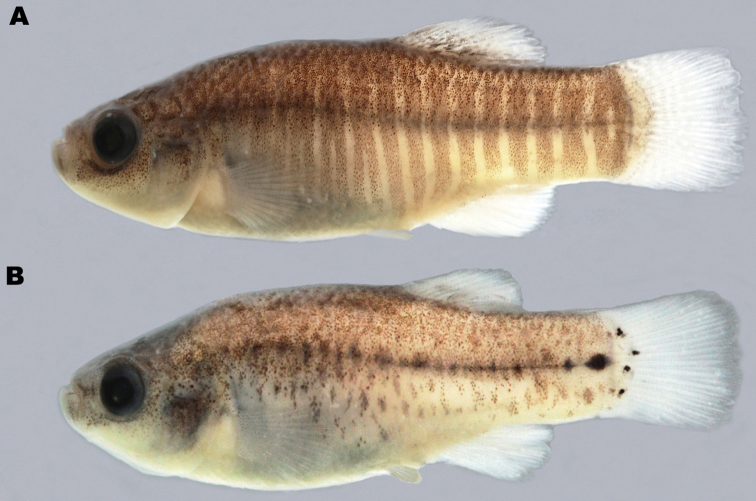
A
Aphanius arakensis, holotype, male, 31.5 mm SL (ZM-CBSU 10999) B paratype, female, 31.5 mm SL (ZM-CBSU 11054).